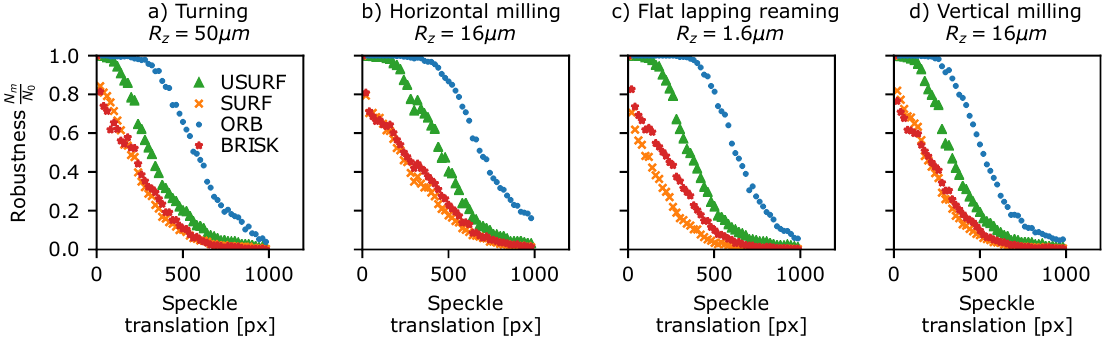
Figure 13. Descriptor translation robustness plotted against measured speckle translation for a selection of surface treatments shown in Figure 1. ( a ) Turning R z = 50 µ m, ( b ) horizontal milling R z = 16 µ m, ( c ) flat lapping reaming R z = 1.6 µ m, and ( d ) vertical milling R z = 16 µ m. Here, the USURF & SURF methods use the standard descriptor length of 64 values, and ORB and BRISK are using 32 × 32 pixel patch sizes.